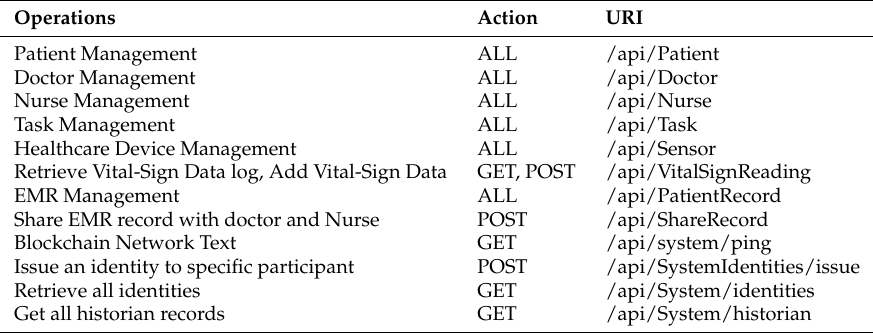
Table 2. RESTful API for proposed healthcare IoT blockchain platform.